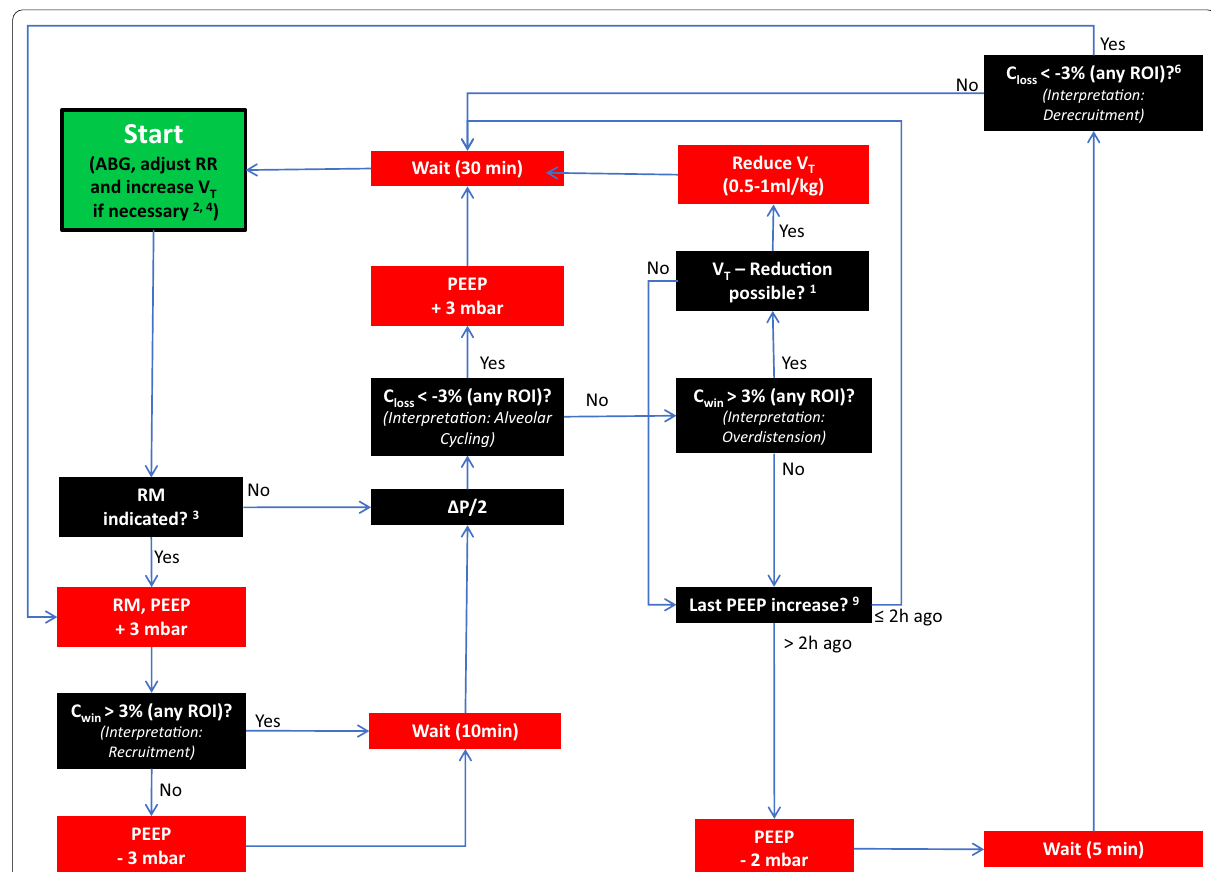
Fig. 1 Clinical protocol for prospective optimization of ventilator settings with electrical impedance tomography (EIT). Optimization started with an arterial blood gas (ABG) analysis and, if necessary, adjustments of respiratory rate (RR) and tidal volume (V T ), followed by a recruitment maneuver (RM) and subsequent adaptations of positive end-expiratory pressure (PEEP) and V T . The footnotes are explained in the Additional file